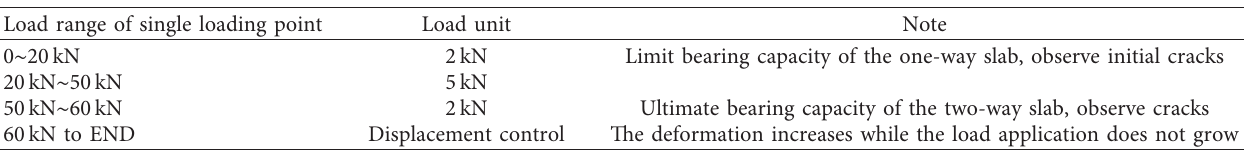
Figure 3: Measurement and loading processes of the test model. (a) Measurement and loading at the model top. (b) Measurement and loading at the model Table 1: Actual loading values.